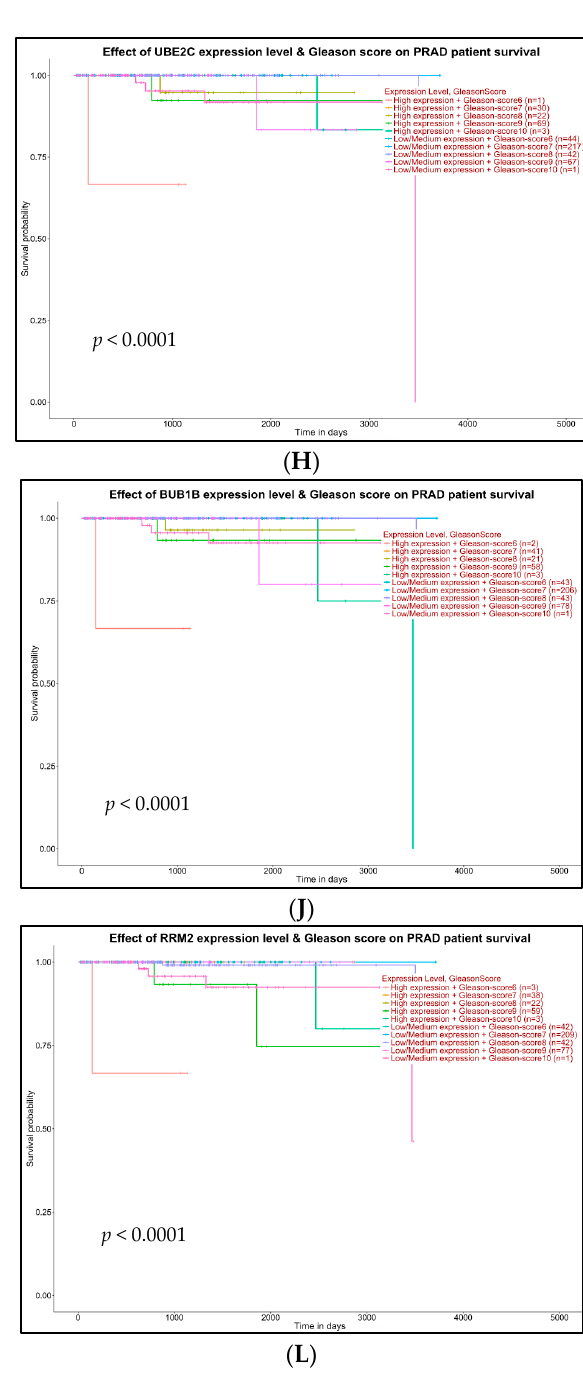
Figure 10. Predictive survival analysis based on the high or low expression of 12 hub genes from TCGA-PRDA in PCa patients was performed using the UALCAN. Survival analysis for 5 up-regulated ( A – E ) and 7 down-regulated ( F – L ) genes is presented. The survival analysis is based on the gene expression level and Gleason scores from the Cancer Genome Atlas Prostate Adenocarcinoma (TCGA-PRAD) patients’ survival. p < 0.05 is considered statistically significant.